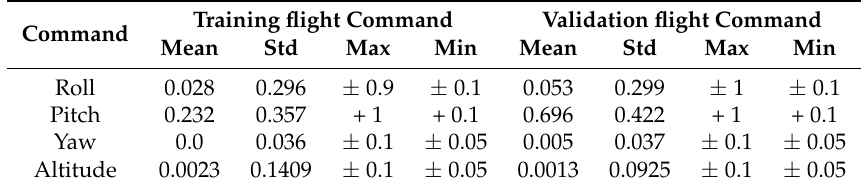
Figure 9. Examples of the dataset collected during the pilot’s flight. Table 2. Distribution of ground truth flight command values associated as labels to the images in the training and validation datasets recorded during a manual